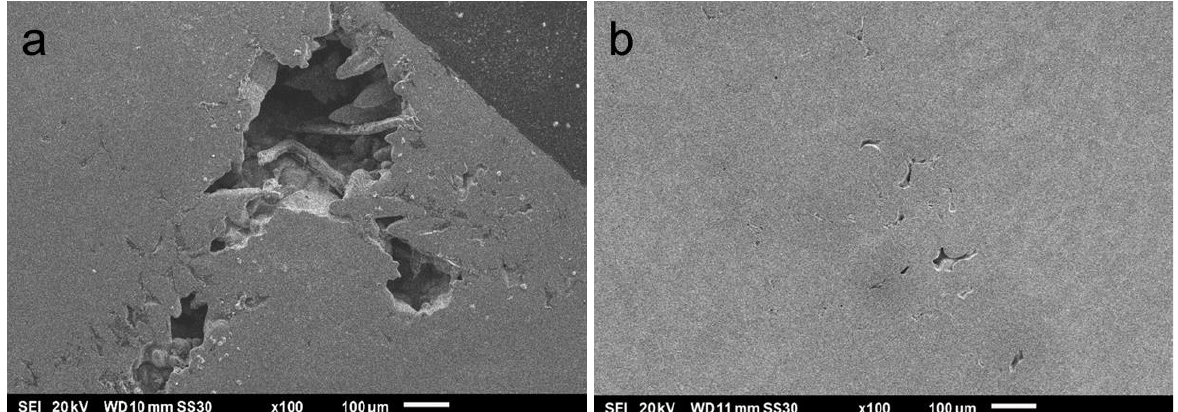
Figure 9. SEM images of BJ impeller surface showing ( a ) large (~400  m) and ( b ) small (~50  m) shrinkage voids due to metal contraction.